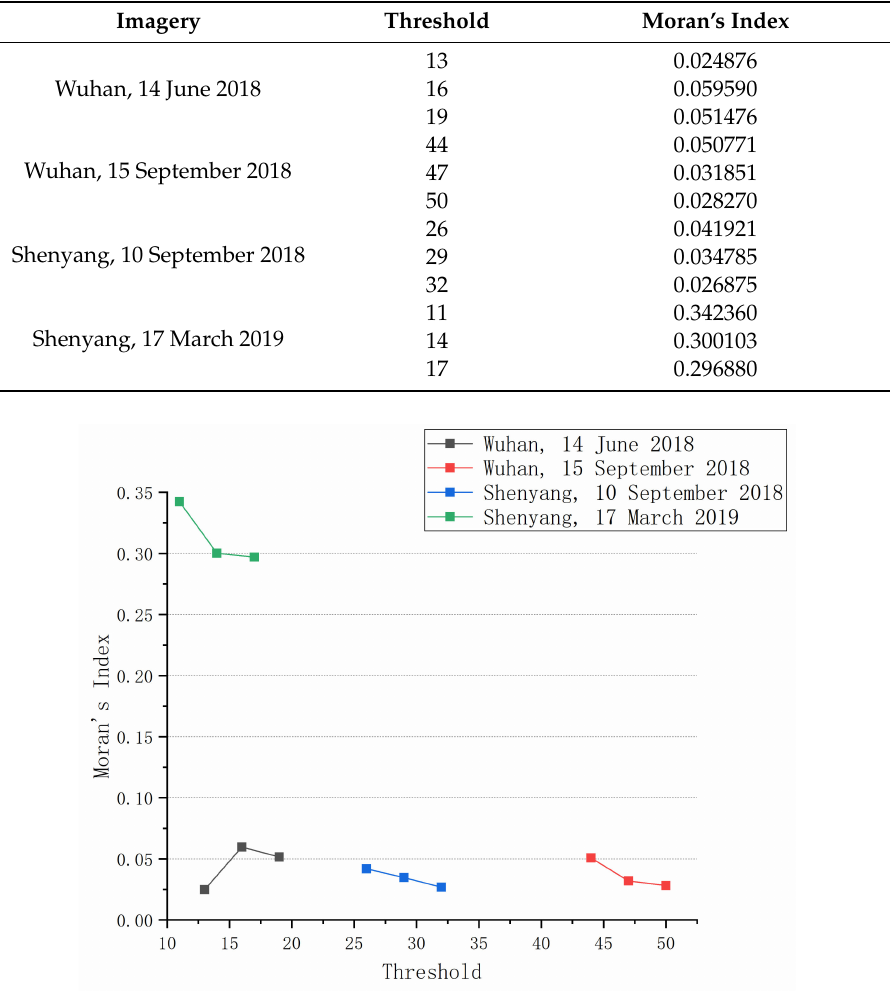
Figure 9. Sensitivity analysis line chart about the binarization